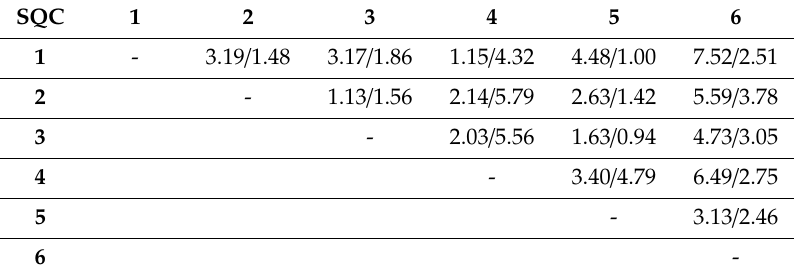
Table 5. The matrix of median di ff erences in bark colour between the structural classes of standing spruce trees ( ∆ E * on the northern side of the breast height section / ∆ E * on the southern side).